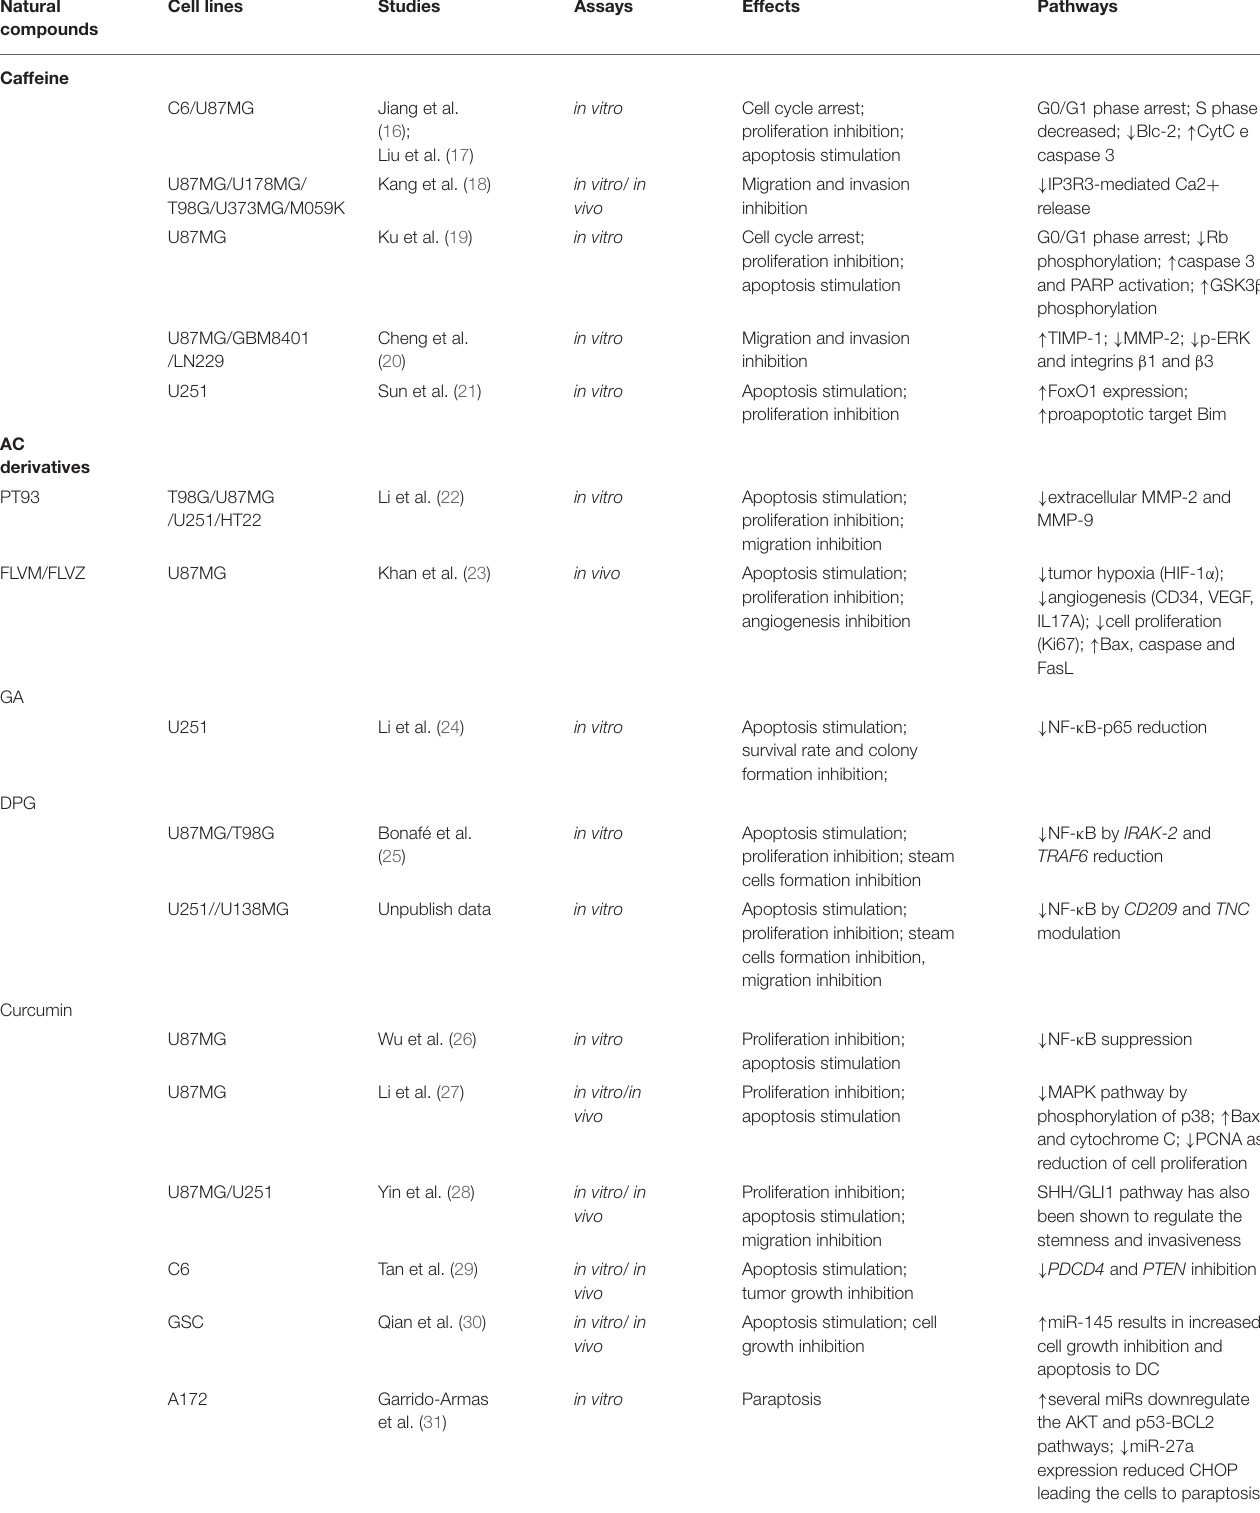
TABLE 1 | The effects of the natural compounds on GBM cell lines (19–22, 41, 47, 49, 54, 63, 69, 83–87, 89, 92, 101). Natural